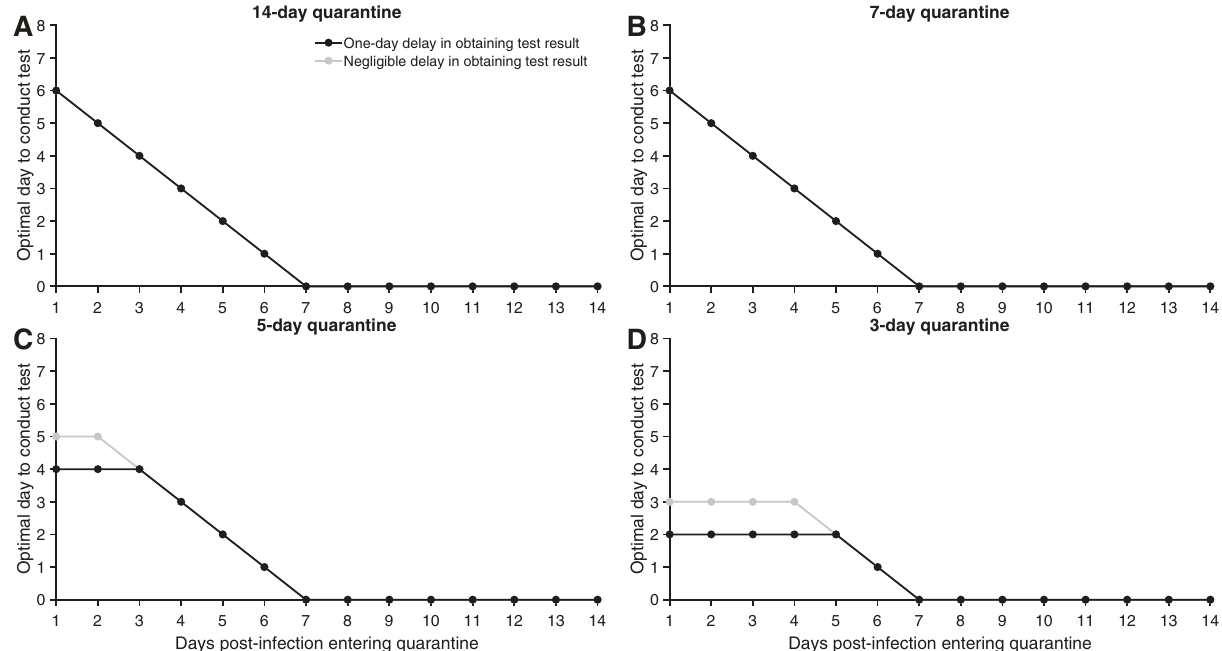
Fig. 4 Optimal testing day for a known time of exposure. For a case whose date of exposure has been identi fi ed as occurring 1 – 14 days prior to quarantine, the optimal day to conduct the RT-PCR test with a 1-day delay (black) and with a negligible delay (gray) in obtaining test results, assuming perfect self- isolation of symptomatic infections, 30.8% asymptomatic infections, an incubation period of 8.29 days, and a quarantine lasting A 14 days, B 7 days, C 5 days, and D 3